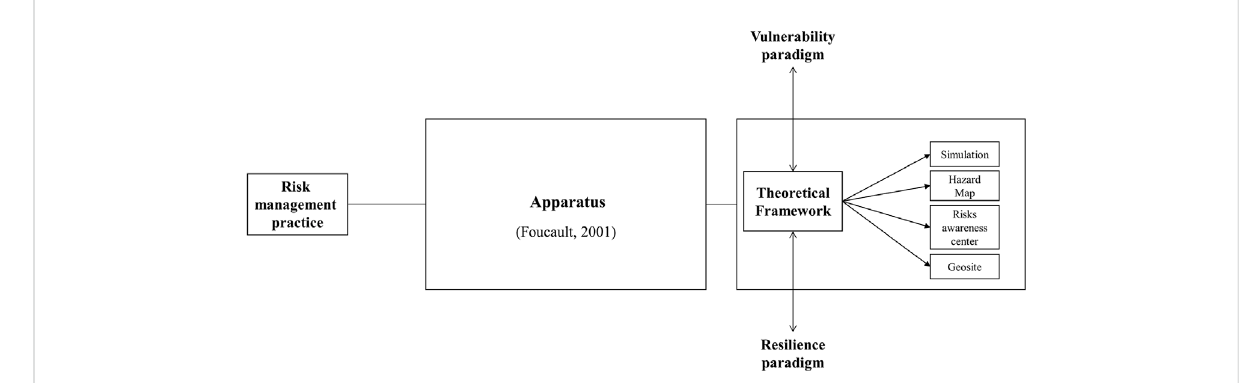
FIGURE 4 Framework for risk management practice between vulnerability and